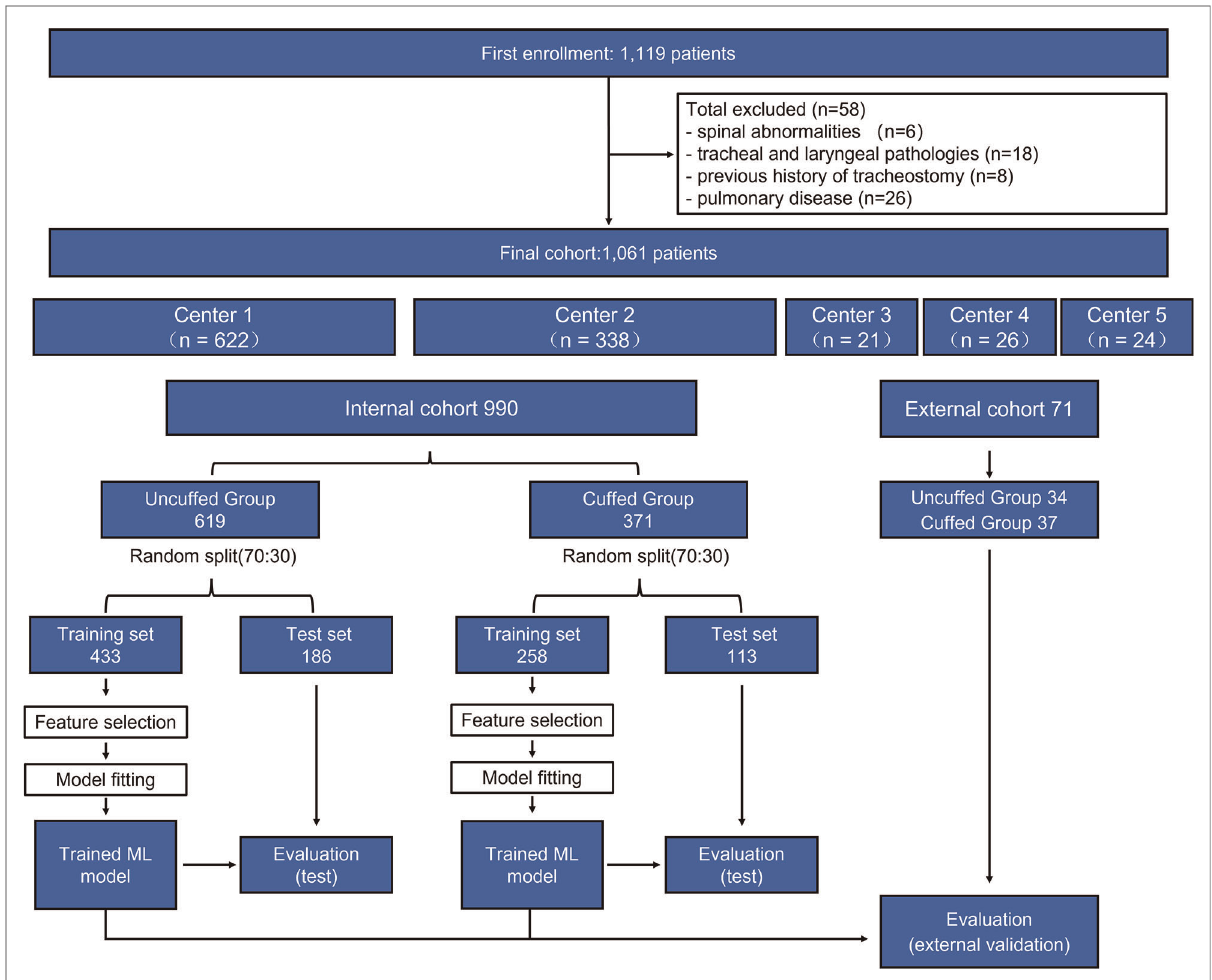
FIGURE 2 Population fl ow chart. In total, 1,061 patients were included in the fi nal analysis (990 in internal cohort and 71 in external cohort). The cohort was further divided into uncuffed and cuffed groups, and each group was divided into training set and test sets. Machine learning (ML) models were built in the training set to perform feature selection and cross-validation. Developed models were then evaluated in the test set and external cohort. Center 1=Shanghai Xinhua hospital; Center 2=Shanghai Changzheng Hospital; Center 3=Children ’ s Hospital of Fudan University; Center